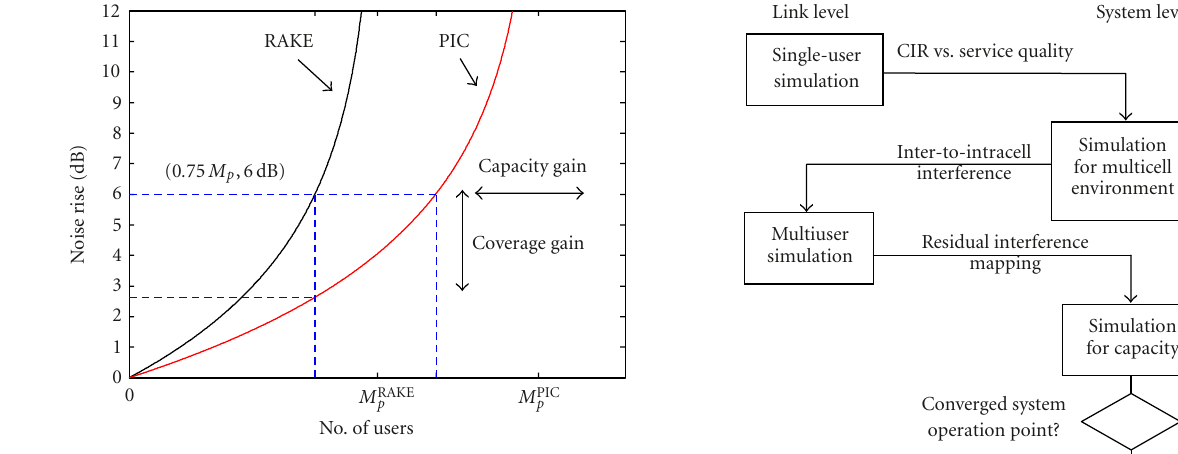
Figure 4: Illustration of the relation between noise rise and number of users for conventional RAKE and PIC.